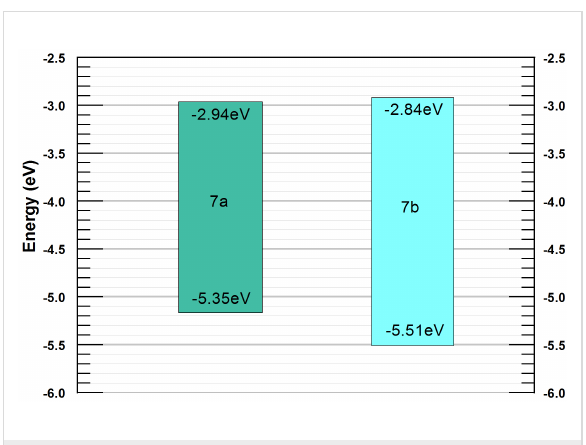
Figure 3: Energy levels of compounds 7a and 7b